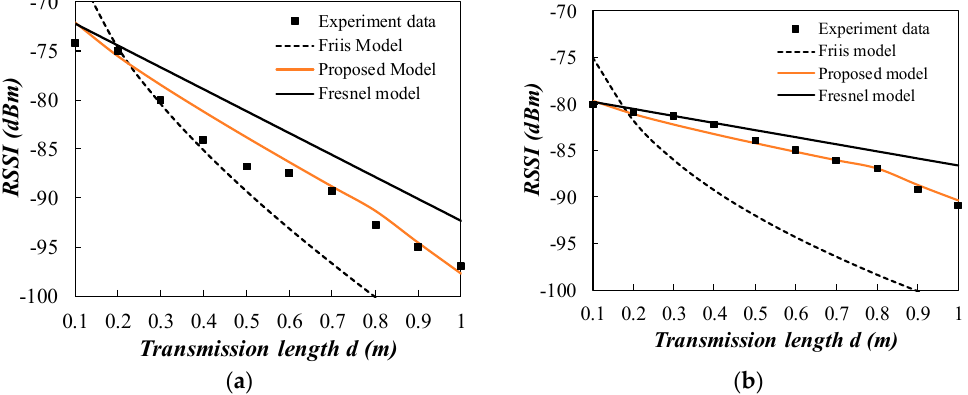
Figure 11. Comparison of the measured experiment data from the literature [31] with the propagation models. ( a ) VWC = 30%; ( b ) VWC = 10%.